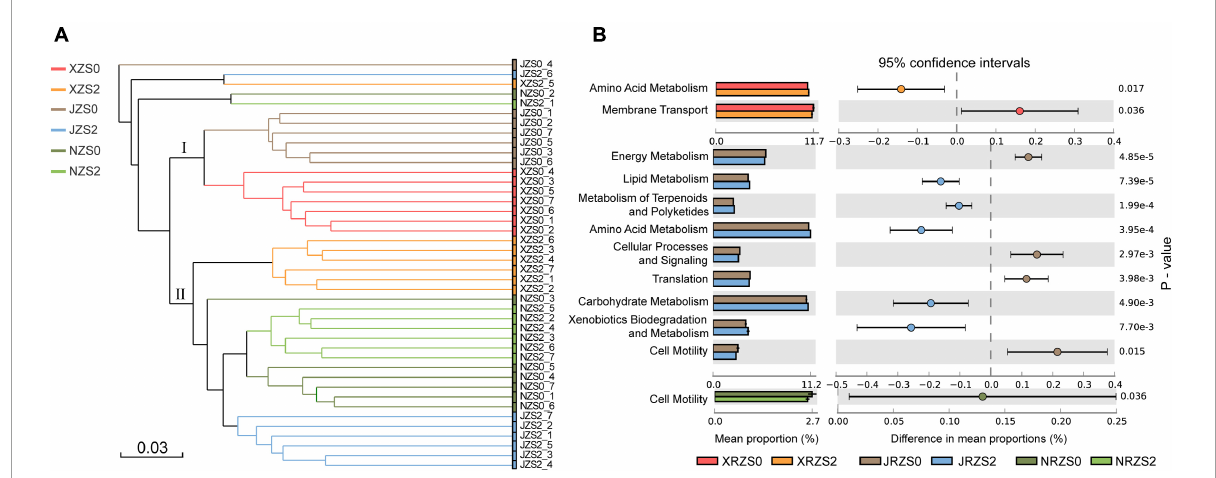
FIGURE6 (A) Clustering analysis of bacterial communities under three rice cultivars and two soil Zn applications based on OTU abundance. Bray–Curtis similarity coefficients were used; (B) KEGG metabolism pathway (L2 level) differing significantly between ZS0 and ZS2 among three different rice cultivars (HHZ, NJ9108, and ND9925) with an effect size ≥ 10%.